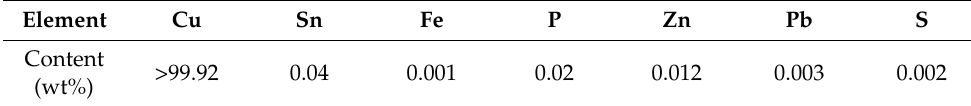
Table 1. Chemical composition of Cu base metal (wt. %).